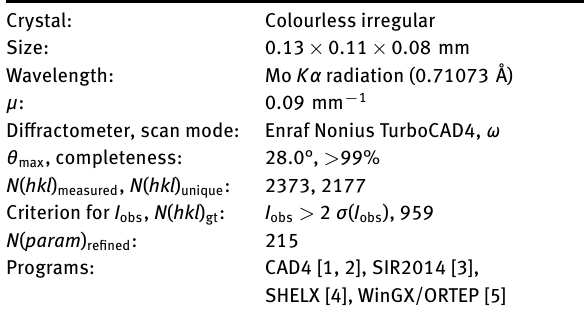
Table 1: Data collection and handling.